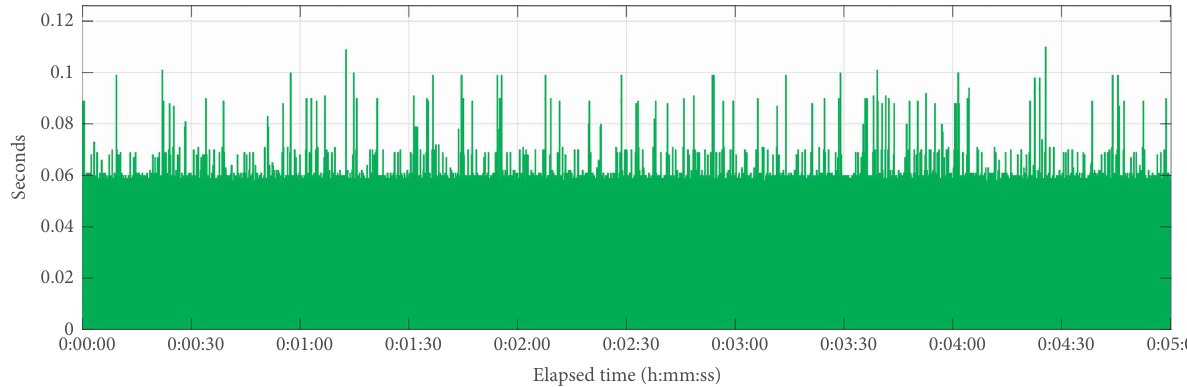
Figure 6: Response time of the near point.